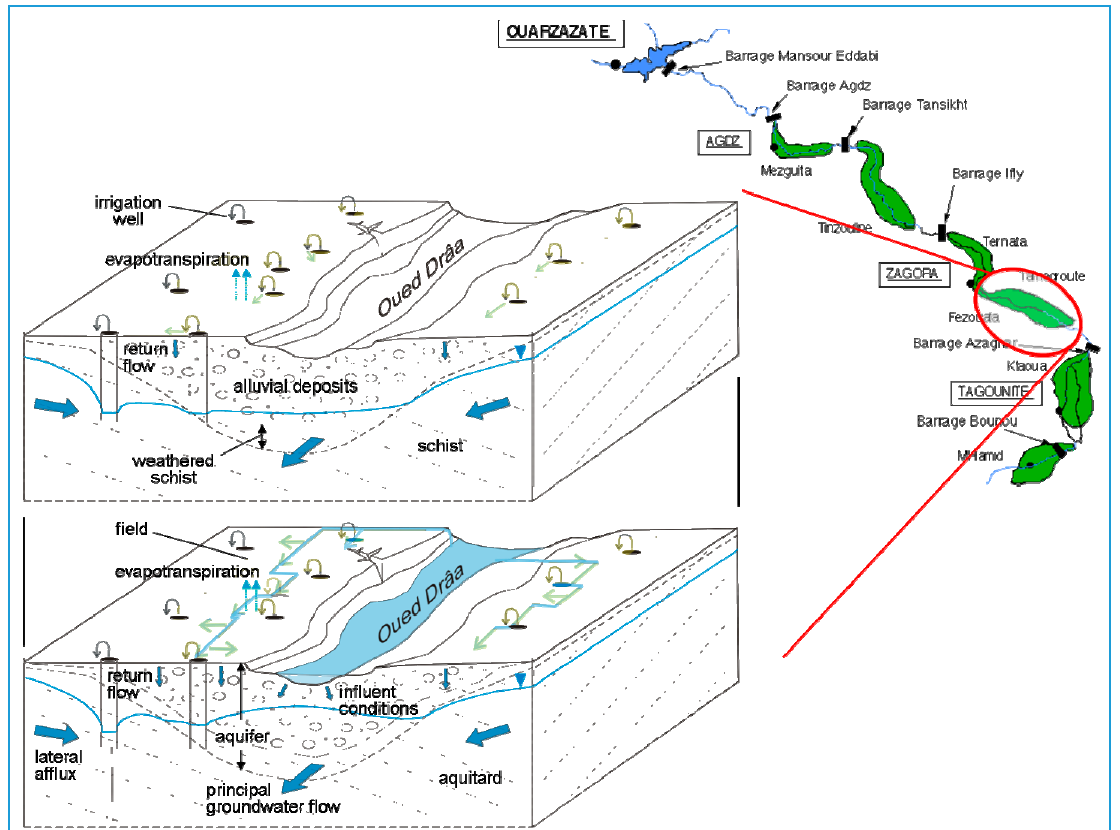
Figure 10. Groundwater flow in the middle Drâa basin. Before (upper panel) and during (lower panel) dam water release [20].